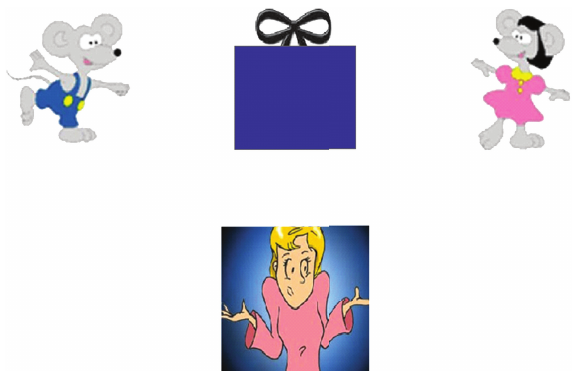
F 1: A screen shot of the task. e present is at top center and is shaded in one of 20 shades from bright pink to dark blue. e boy mouse at le is supposed to receive blue presents and the girl mouse is to receive pink presents. e shrugging character (the Helper) at bottom is the uncertainty response stimulus, and when presents are given to her they are then routed to the correct